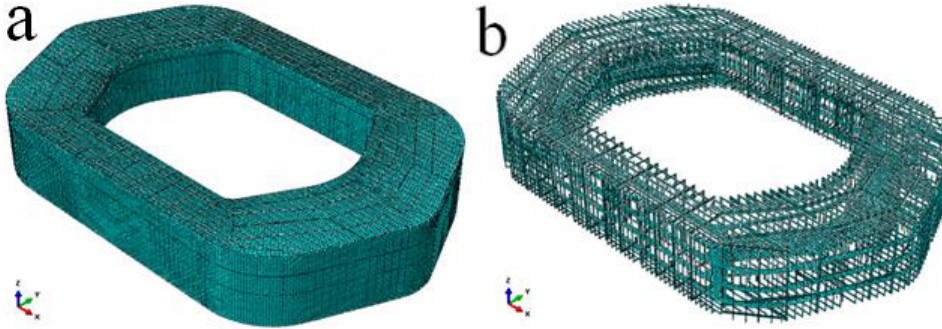
Figure 3. FE model of the protective device ( a ) Integration sketch and ( b ) Inner frame sketch.